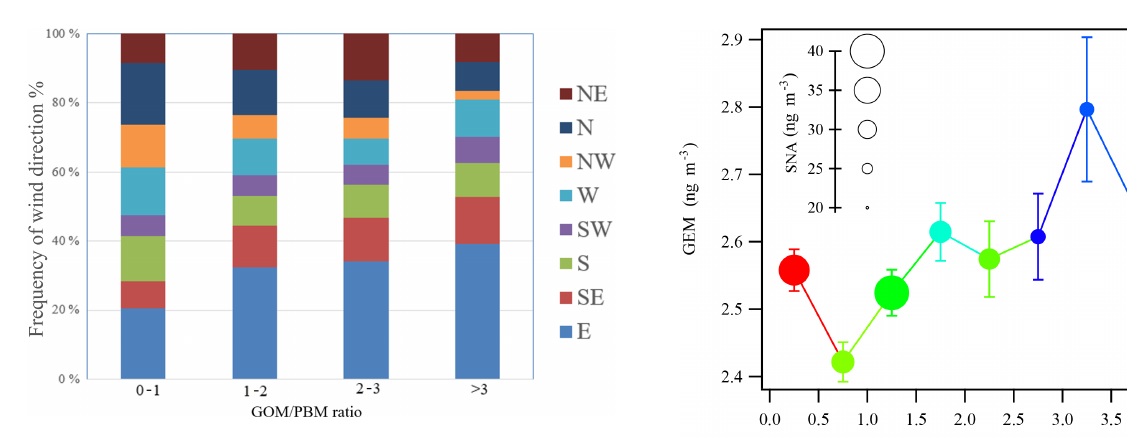
Figure 8. Frequency of wind directions under different ranges of GOM / PBM ratios. Figure 9. The GEM concentrations as a function of the GOM / PBM ratios in each bin of 0.5. The dots are colored by the concentrations of CO, and the sizes of the dots represent the con- centrations of SNA in PM 2 . 5 . The bars represent 1 standard error of GEM concentration in each